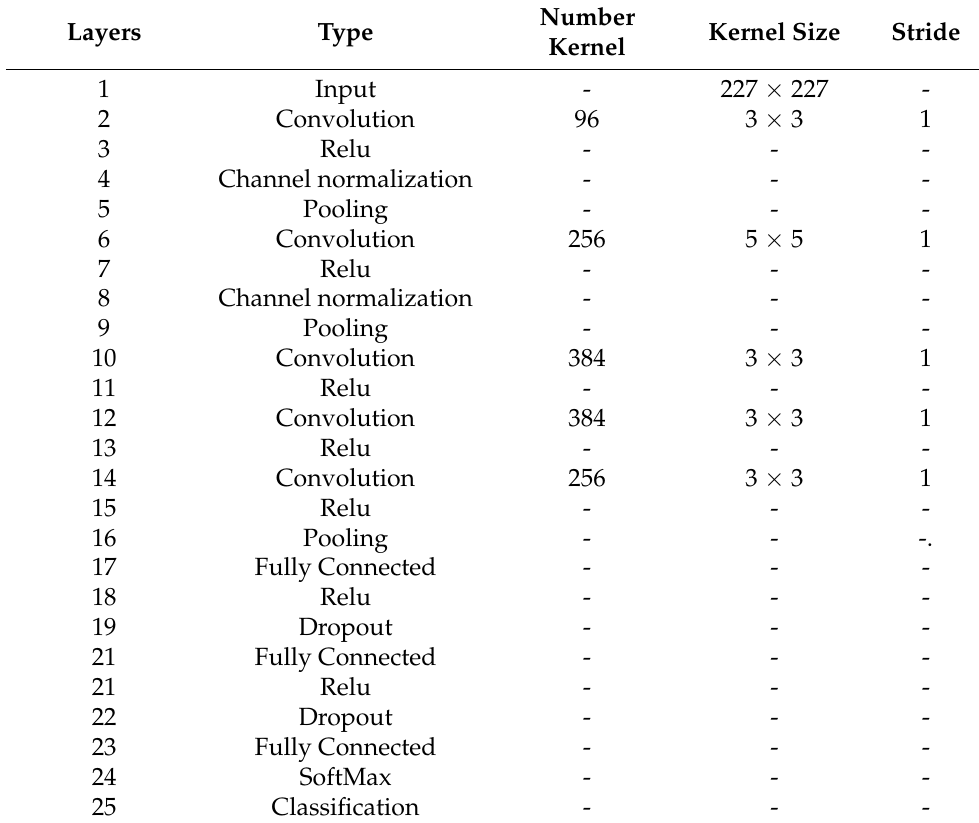
Table 4. Parameter of Alex